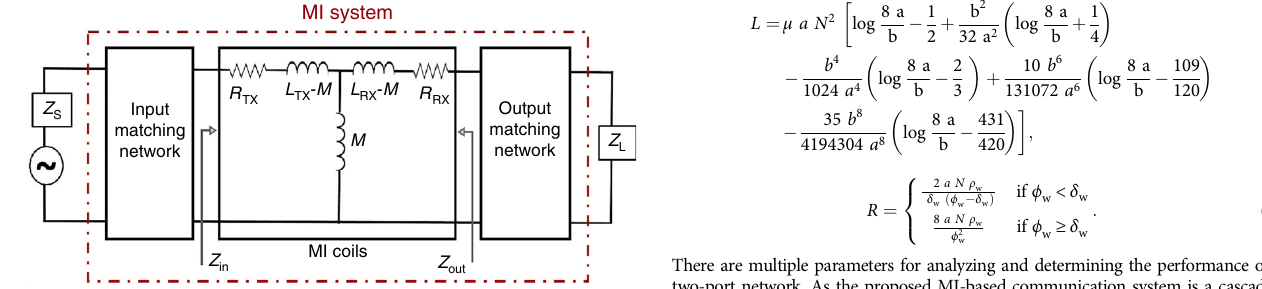
Fig. 6 Equivalent two-port network model of magnetic induction (MI) system. The model is integrated with input and output matching networks, and M , L TX , R TX , L RX , and R RX are the mutual inductance between coils, inductance, and resistance of transmitter and receiver coils,